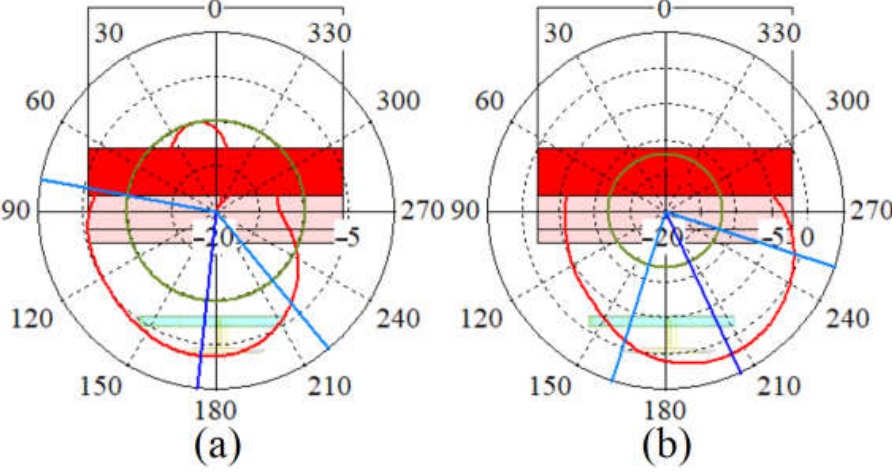
Figure 14. The simulated radiation pattern of the antenna on-body tissue at ( a ) 3.4 GHz, ( b ) 5.6 GHz.